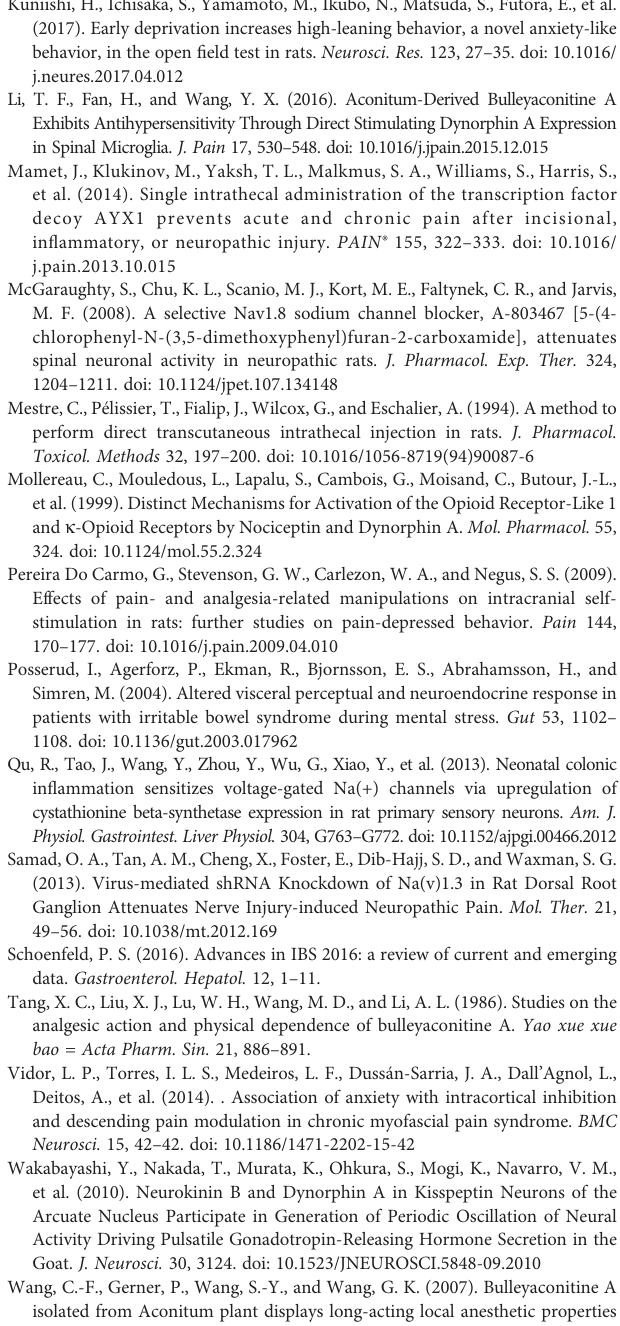
SUPPLEMENTARY TABLE 1 | HeICS protocol was used to aggravate visceral pain and induce anxiety behaviors in rats. Table 1. Each rat from HeICS group were treated with the validated protocol as